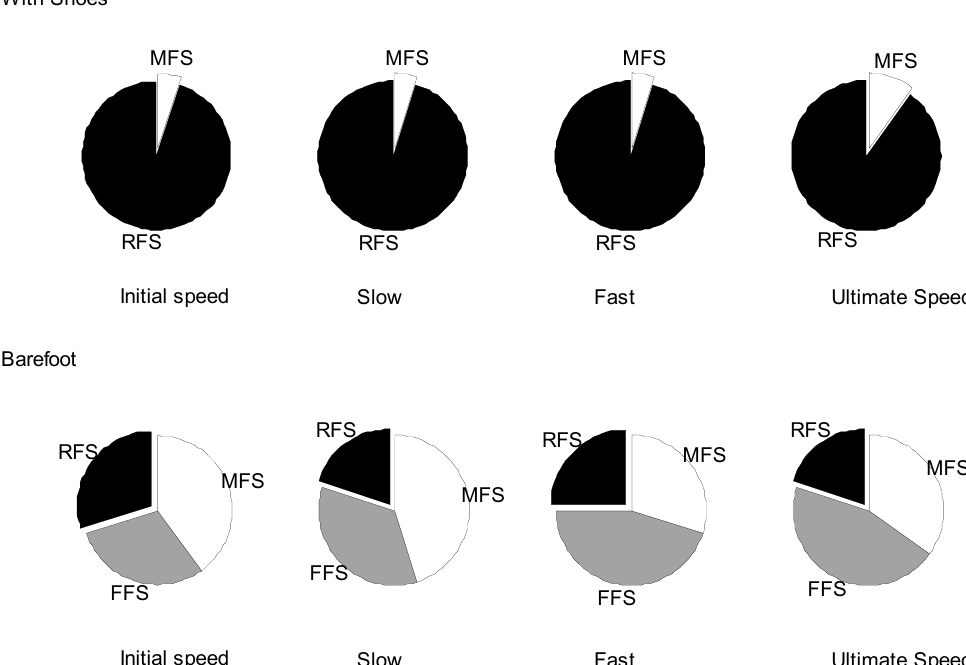
Figure 2. Frequency distribution of three landing patterns when running with or without shoes at four di ff erent speeds (FFS: forefoot strike, MFS: midfoot strike, RFS: rearfoot strike).